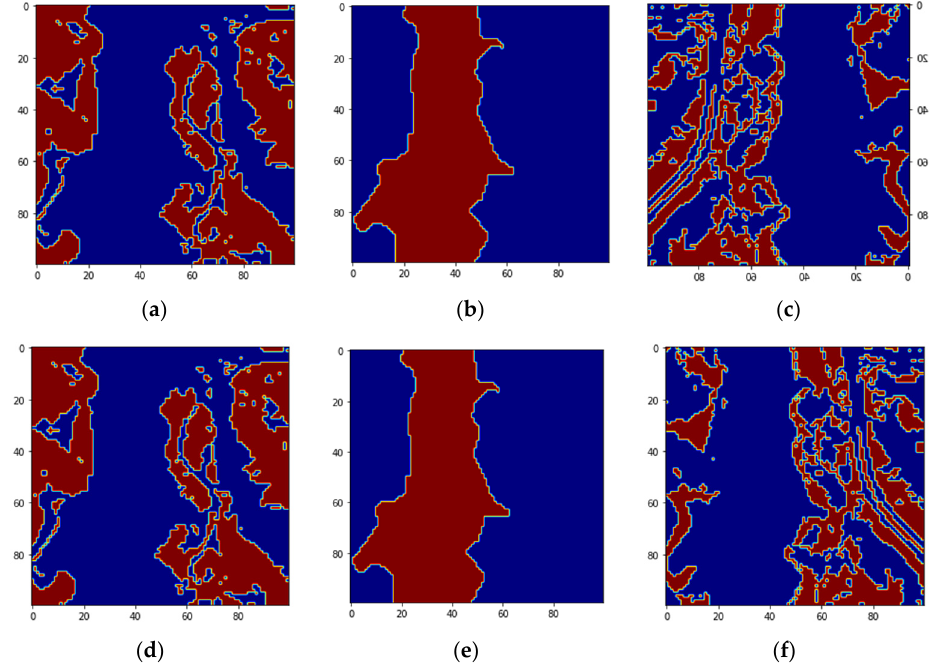
Figure 17. ( a ) Tree class reconstructed image with label 0 (blue) for pixels Not Belonging to tree class, label 1(brown) for pixels Belonging to tree class. ( b ) Water class reconstructed image with label 3 (blue) for pixels Not Belonging to water class, and label 4 (brown) for pixels Belonging to water class, ( c ) Soil class reconstructed image with label 6 (blue) for pixels Not Belonging to soil class, and label 7 (brown) for pixels Belonging to soil class, ( d ) Original groundtruth for tree class, ( e ) Original groundtruth for water class, and ( f ) Original groundtruth image for soil class.